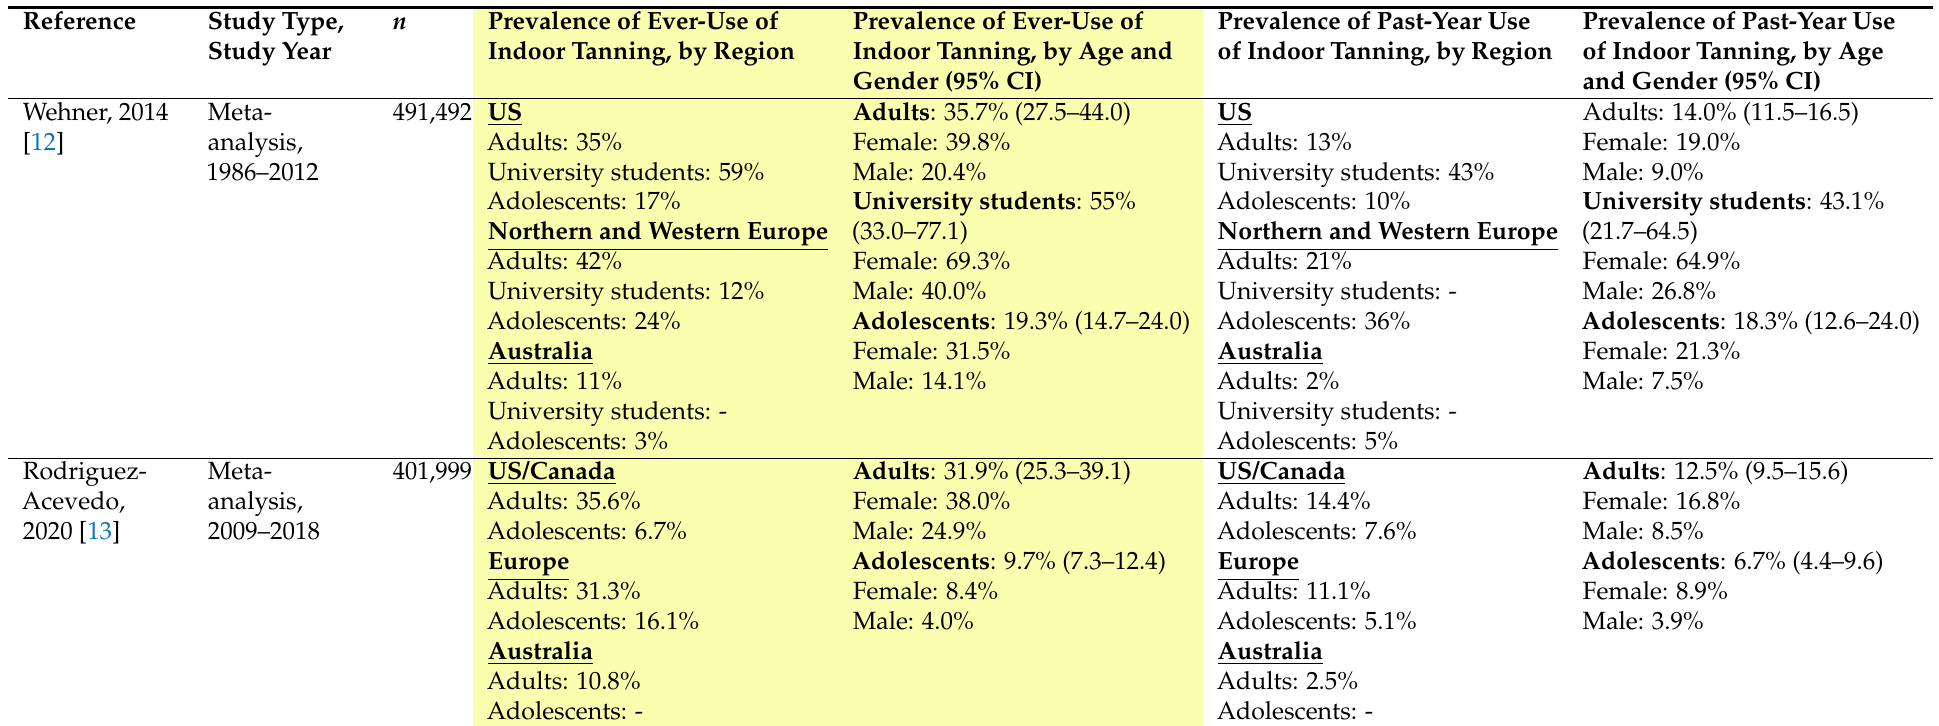
Table 1. A summary of recent publications with international results on the prevalence of indoor UVR tanning across